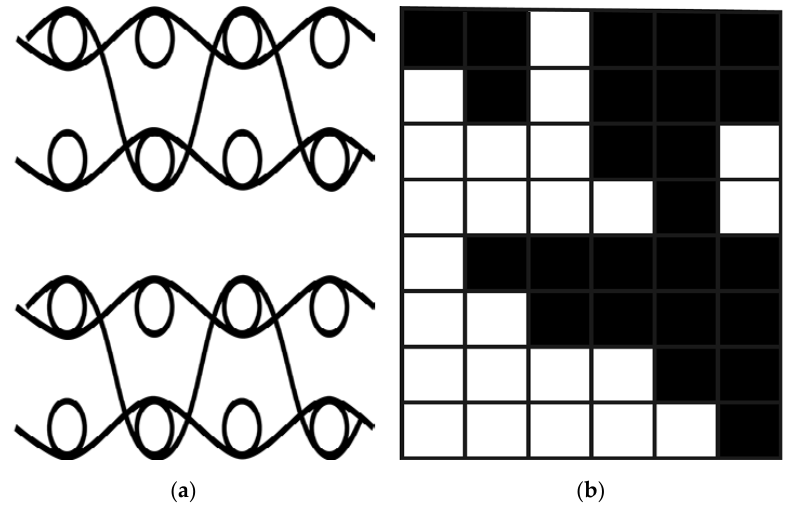
Figure 3. The chain drafts of the 3D tubular woven fabric: ( a ) The warp section drawing; ( b ) The chain